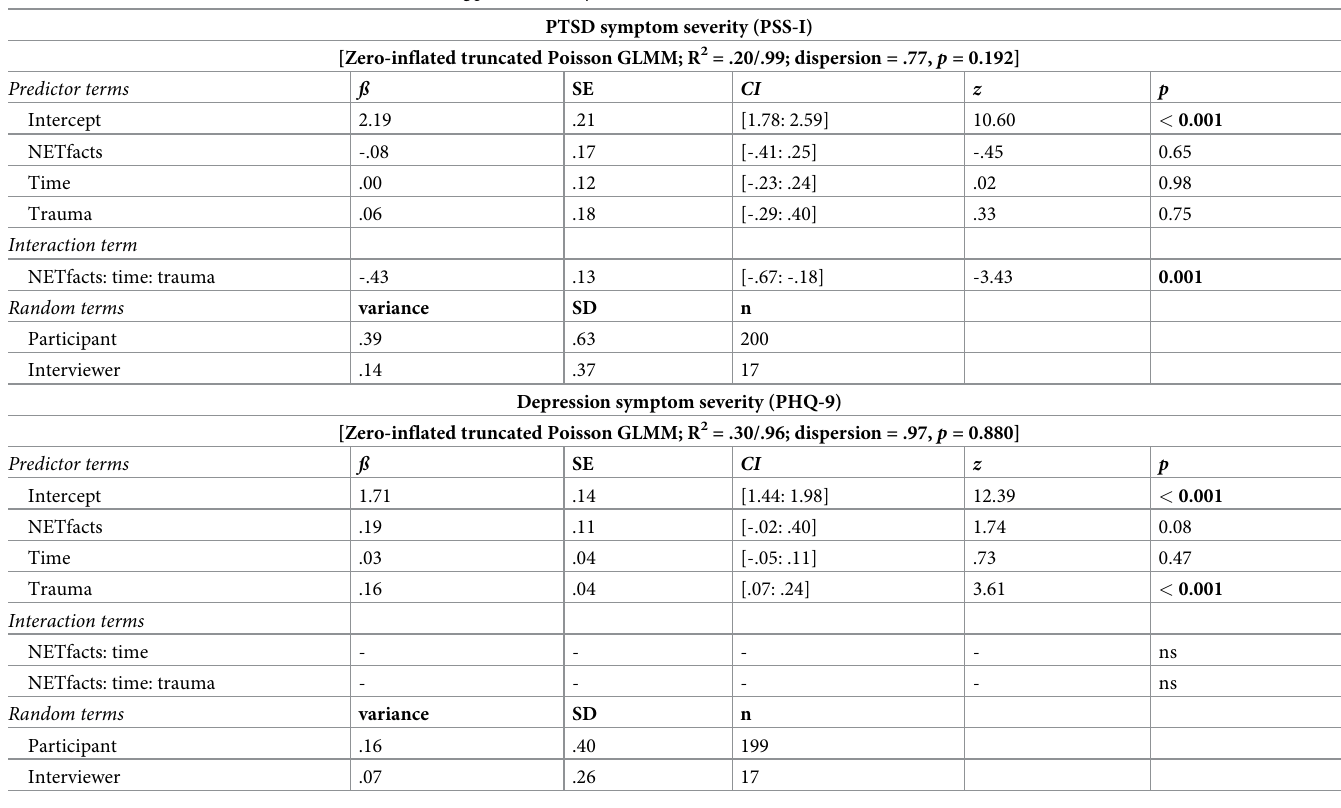
Table 1. GLMMs summary for PTSD and depression symptom severity (clinical outcomes). GLMMs were used to test the predictors of NETfacts (no direct vs. direct involvement), time (baseline vs. post follow up), trauma (number of traumatic events), and their interaction on PTSD and depression symptom severity. Marginal and con- ditional R 2 fit, and dispersion test estimates are shown for each outcome. Standardized model estimates, standard errors, standardized confidence intervals, z and p values are shown for the predictor terms. Random terms are represented as variance, standard deviation and sample size. Note that only the count model part of the